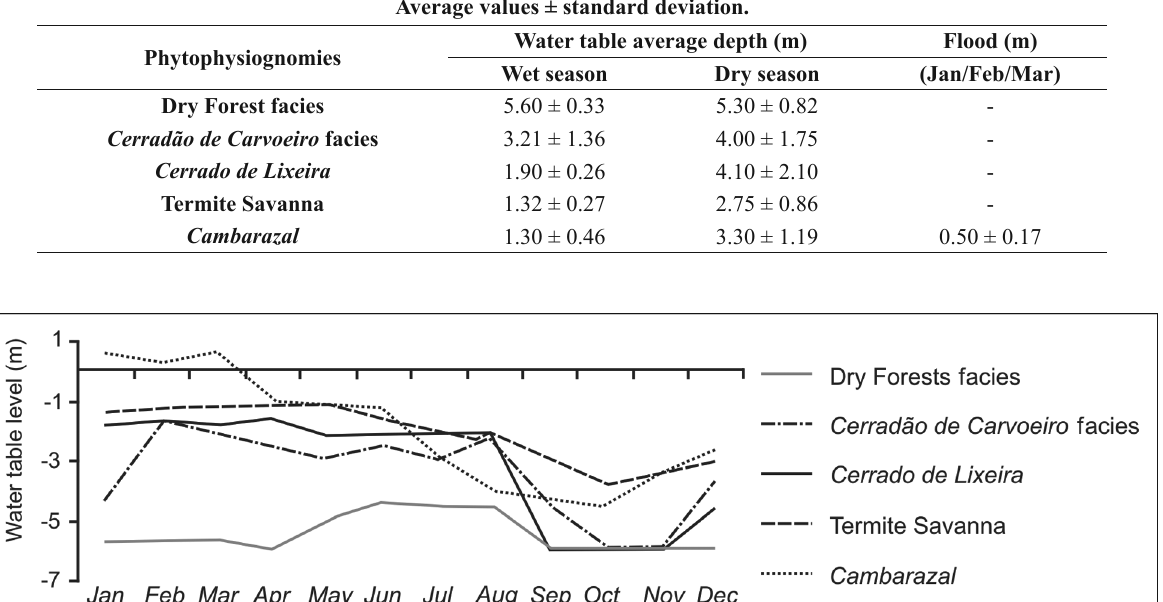
Figure 3 - Mean values (m) of annual range of water table depth and fl ood height in the studied formations in RPPN SESC Pantanal, Brazilian Pantanal.